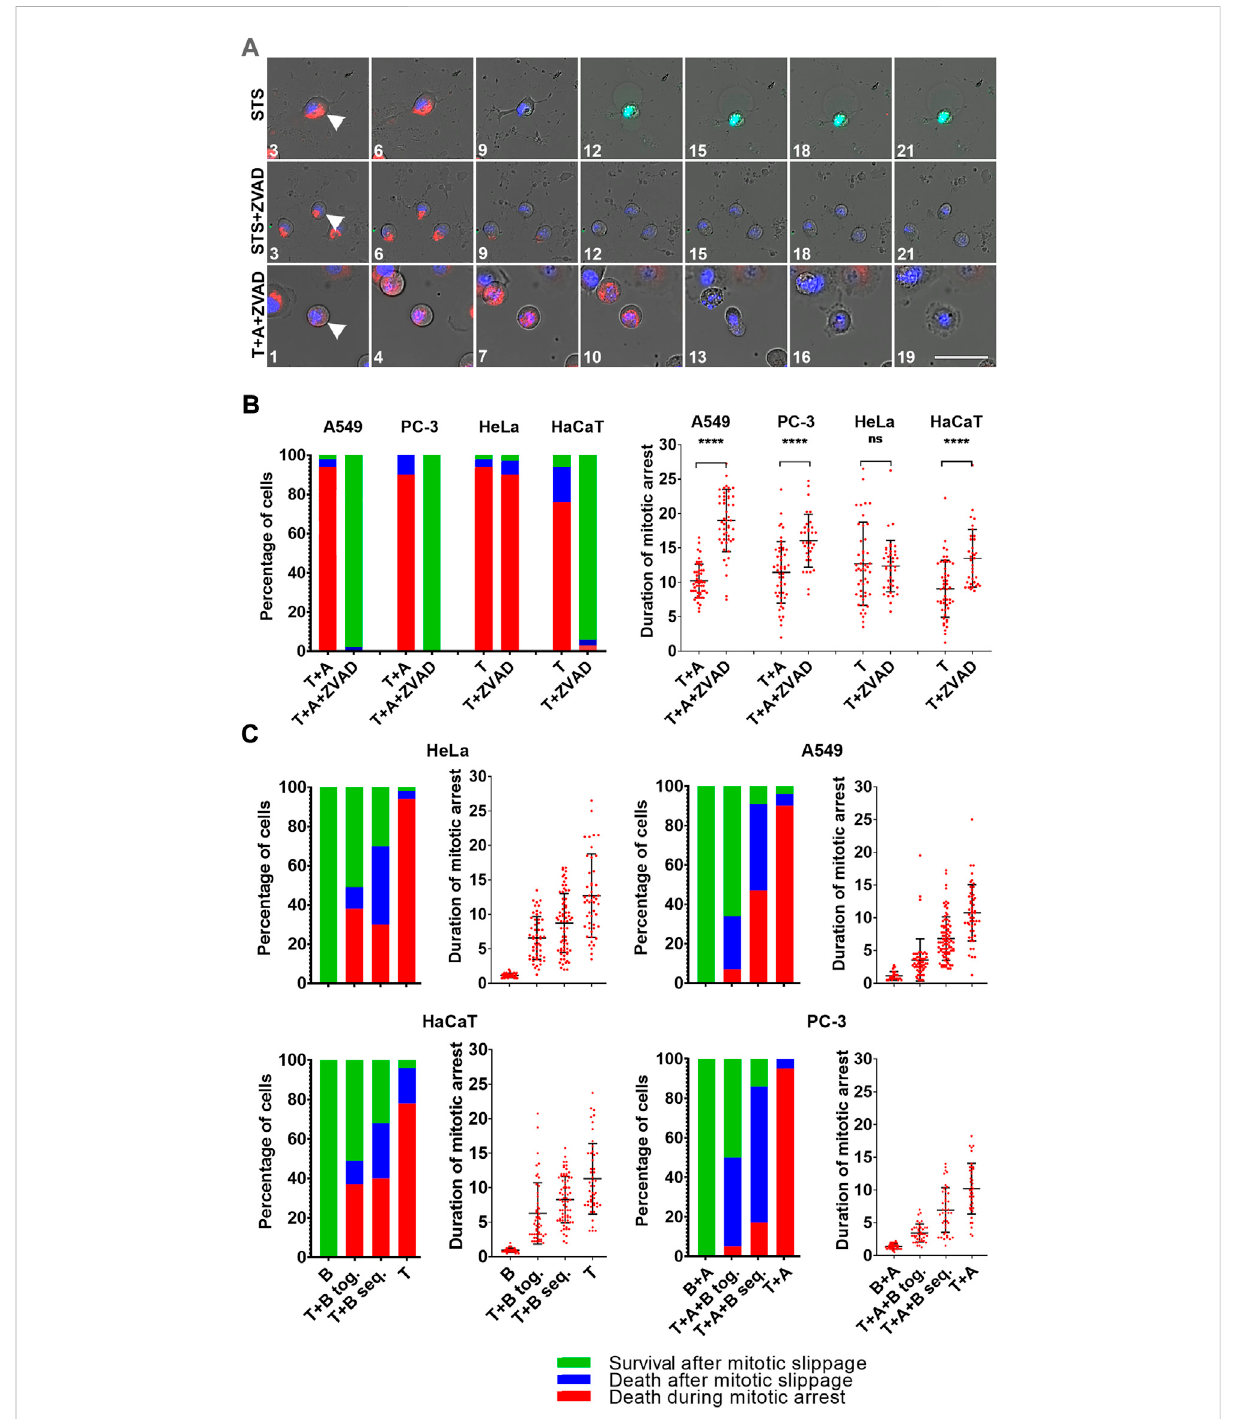
FIGURE 4 (A) Time-lapsesequencesofA549cellstreatedwithstaurosporine(STS),staurosporine+Z-VAD(OH)-FMK(STS+ZVAD),orTaxol+A-1155463 + Z-VAD(OH)-FMK (T + A + ZVAD). For staurosporine treatment, numbers indicate hours since drug addition. For Taxol treatment numbers indicate hours since mitotic entry. Mitochondrial membrane potential is shown in red, caspases 3/7 in green, and DNA in blue. Images were obtained using×20/0.8objective.Scalebar=50 µm. (B) Distributionoffatesandaveragedurationsofmitoticarrest(inhours)ofA549andPC-3cellsthat weresensitizedto DiMwith10 µMA-1155463 (A) andDiM-sensitive HeLaandHaCaT celllines after treatment with1 µMTaxol(T)intheabsence and presence of 100 µM pan-caspase inhibitor Z-VAD(OH)-FMK (ZVAD). (C) Dependence of the outcome of mitotic arrest on its duration in DiM- sensitive HeLa and HaCaT cells, and A549 and PC-3 cells that were sensitized to DiM with 10 µM A-1155463 (A) . For each cell lines, the longest average duration of mitotic arrest was obtained after treatment with 1 µM Taxol (T) (+A for A549 and PC-3) and the shortest with 300 nM barasertib (B) (+A for A549 and PC-3). Duration of mitotic arrest was manipulated using simultaneous treatment with Taxol and barasertib (T+(A+) B tog.) or sequential treatment with Taxol followed by addition of barasertib 24 h later (T+(A+)B